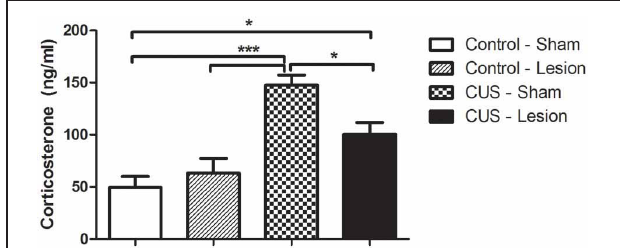
FIGURE 2 | Corticosterone levels measured in the plasma of rats collected from 9 to 10a.m. CUS induces an increase in corticosterone levels when comparing with controls. Interestingly, stressed animals lesioned in the CeA display an attenuation of this increase in corticosterone levels. CUS, chronic unpredictable stress; ∗ p < 0 . 05; ∗∗∗ p < 0 . 001. Results are presented as Mean +